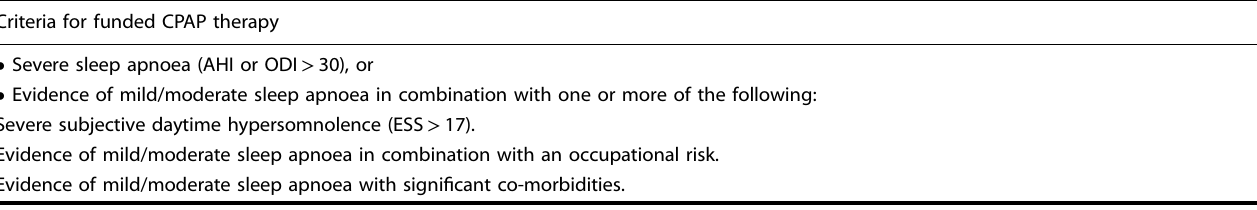
Table 1. Criteria for funded CPAP therapy in Canterbury Criteria for funded CPAP